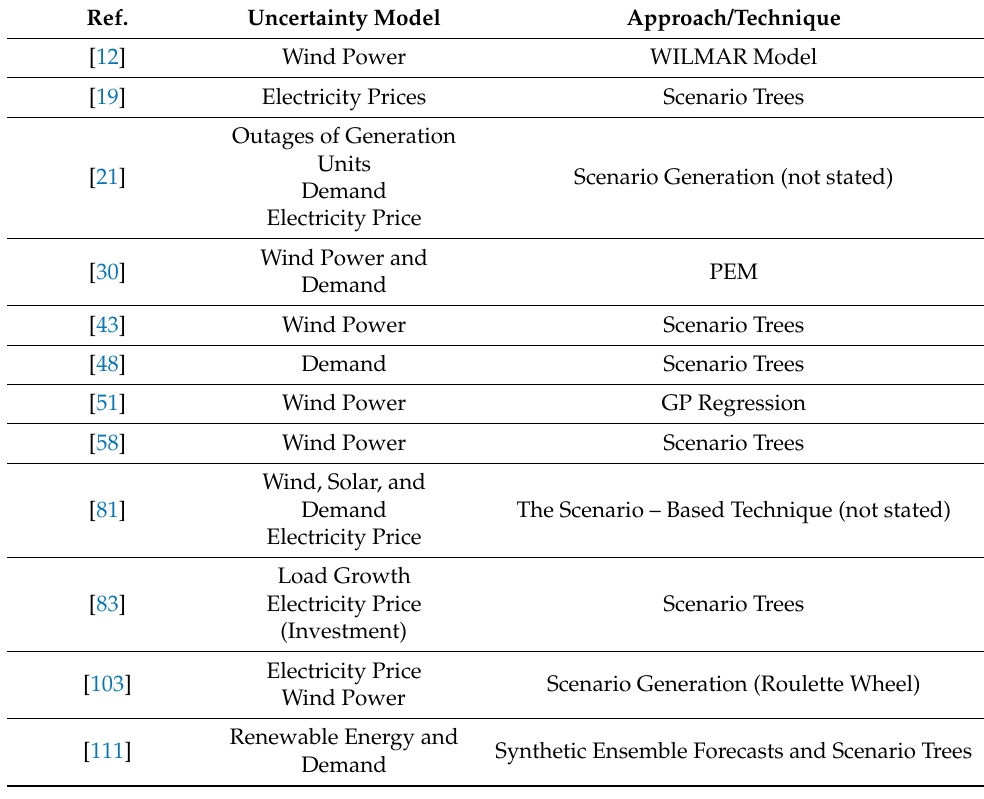
Table 10. Studies In Which Scenario-based Is Used.